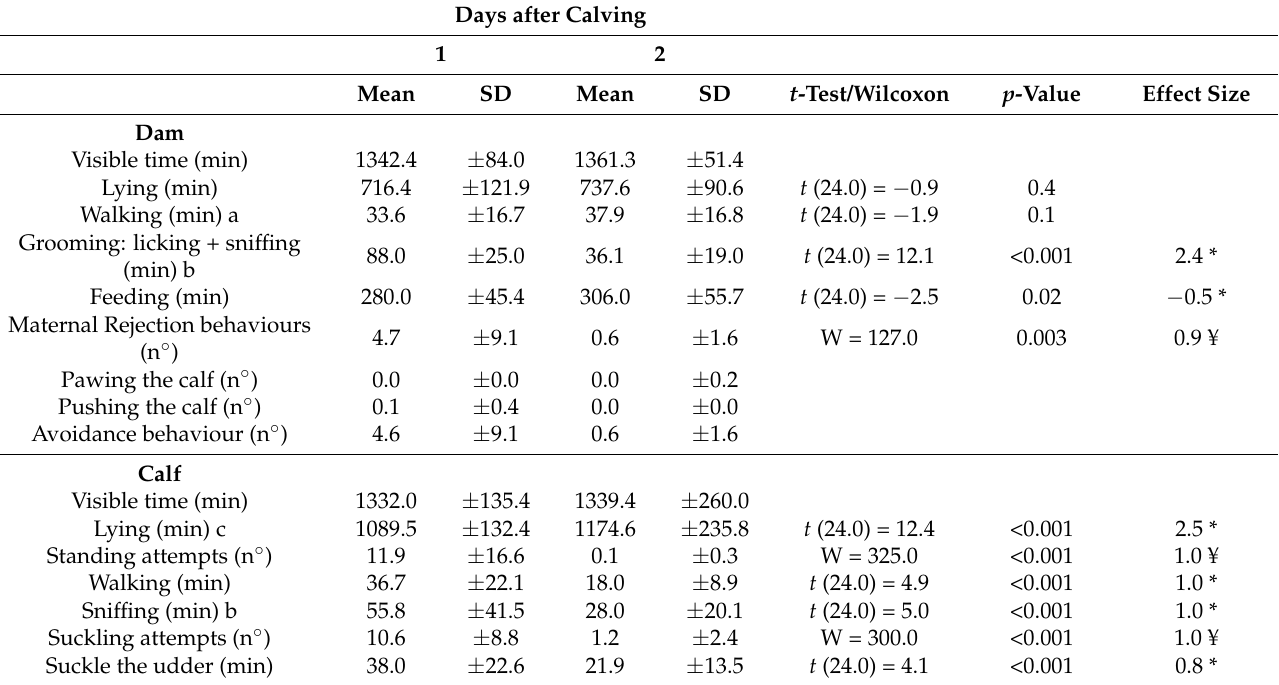
Table 3. Behaviours during the first two days after calving.